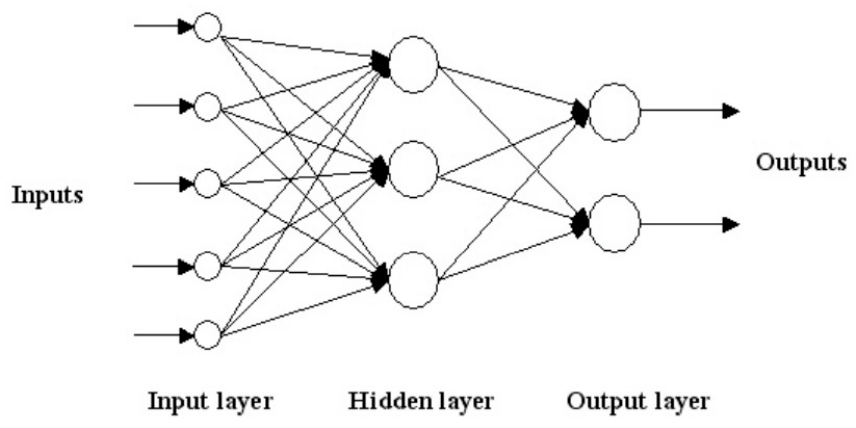
Figure 11. Multilayer Perceptron Schematic Representation.